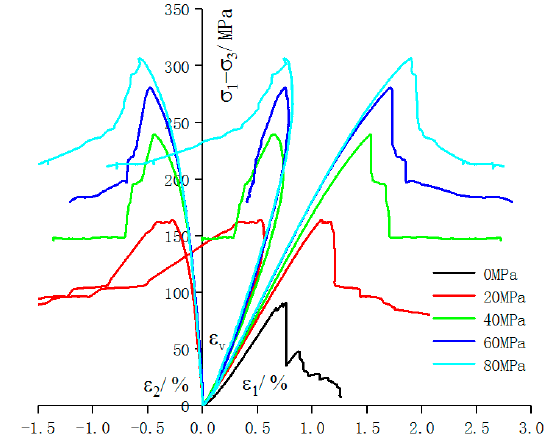
Figure 4. Schematic diagram of the MTS test machine structure.